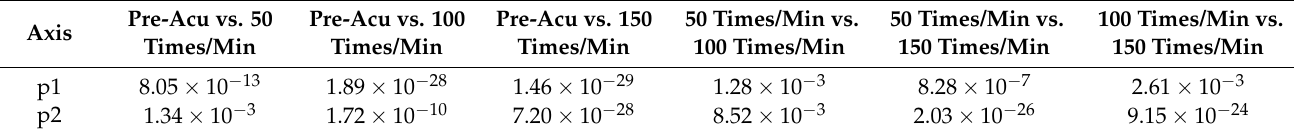
Table 2. ANOVA 1 analysis for comparison of the length of the long and short axes in different states, respectively. Pre-Acu vs. 50 Axis